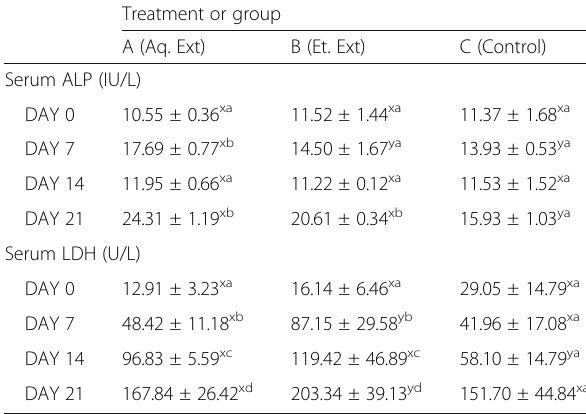
Data represent Means ± S.E.M ( n = 6). Means with different letter a, b superscripts, along column, are significantly different ( p < 0.05). Means with different letter x, y superscripts, along row, are significantly different ( p < 0.05)